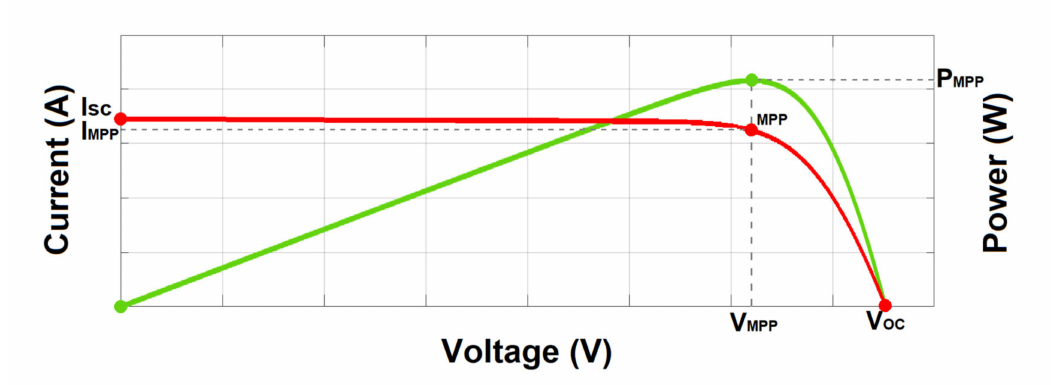
Figure 2. Current-voltage (I-V) and power-voltage (P-V) characteristic curves of a photovoltaic (PV) module